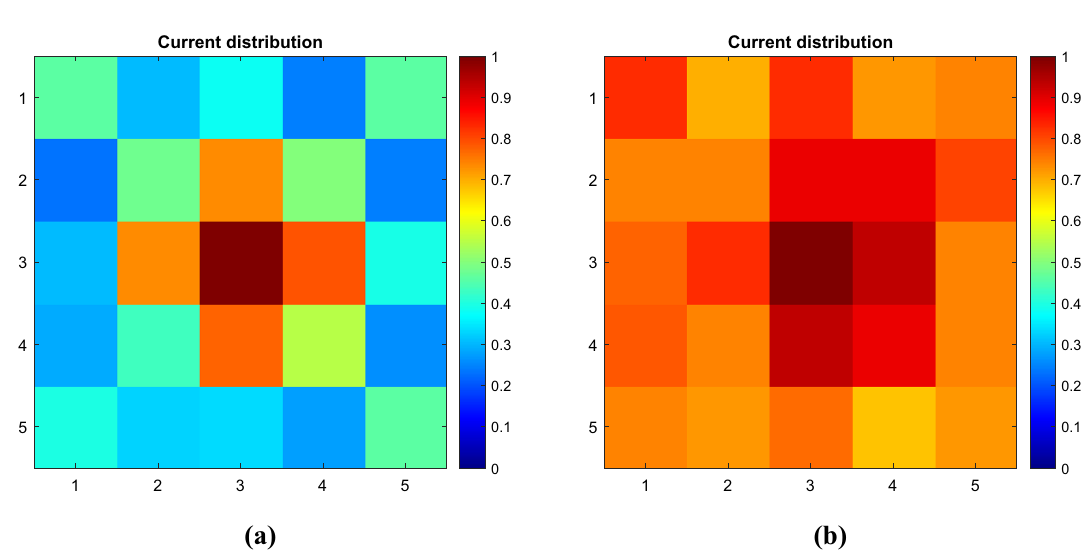
Figure 12. Representation of: ( a ) measured current distribution on the standard metasurface, ( b ) measured current distribution on the homogenized